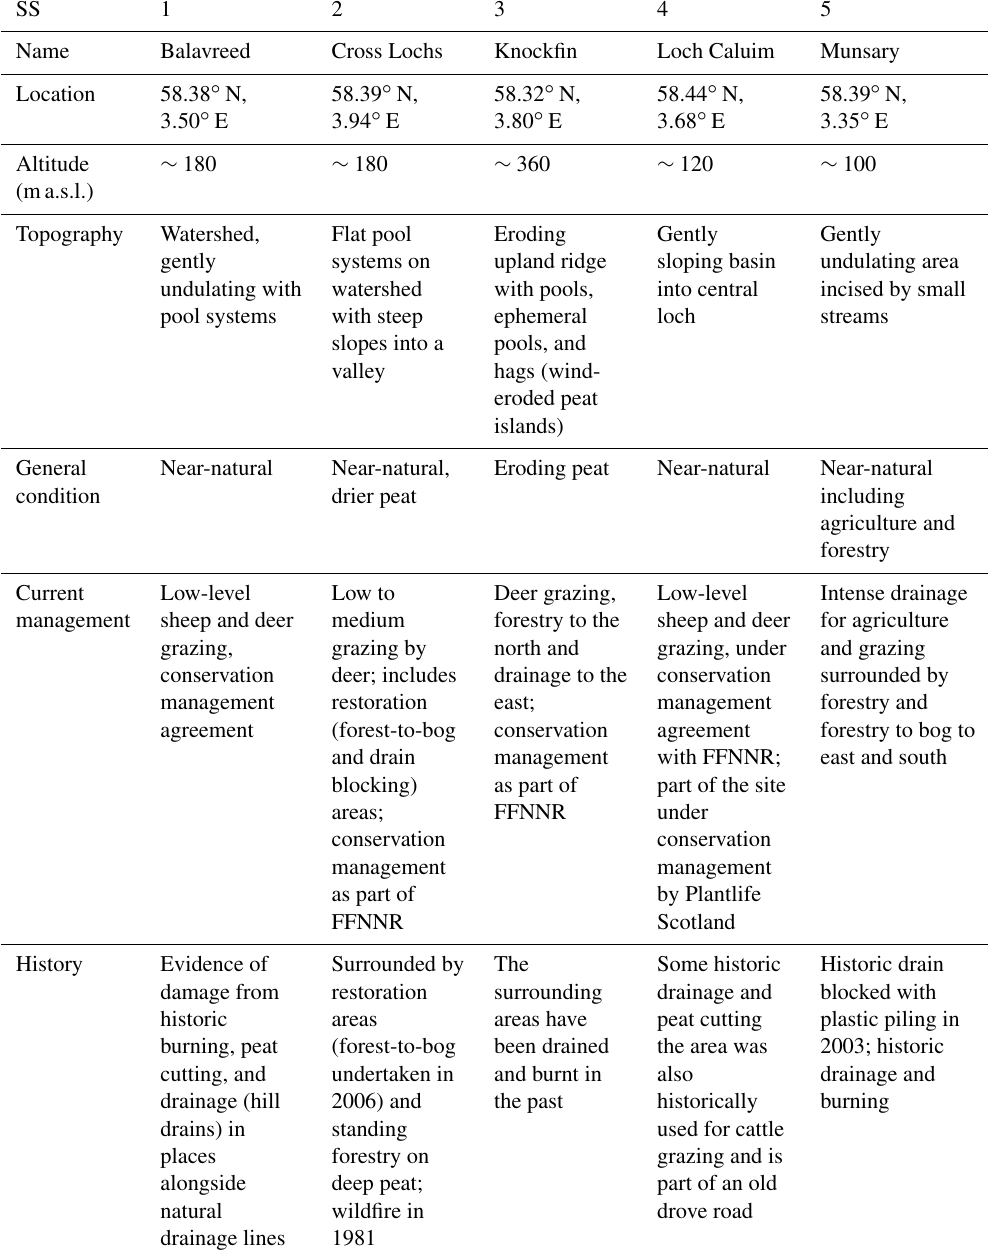
Table 1. Details of the five sub-sites (SSs), which are all currently designated Site of Special Scientific Interest (SSSI), Special Protection Areas (SPA), and Special Areas of Conservation (SAC). FFNNR: Forsinard Flows National Nature